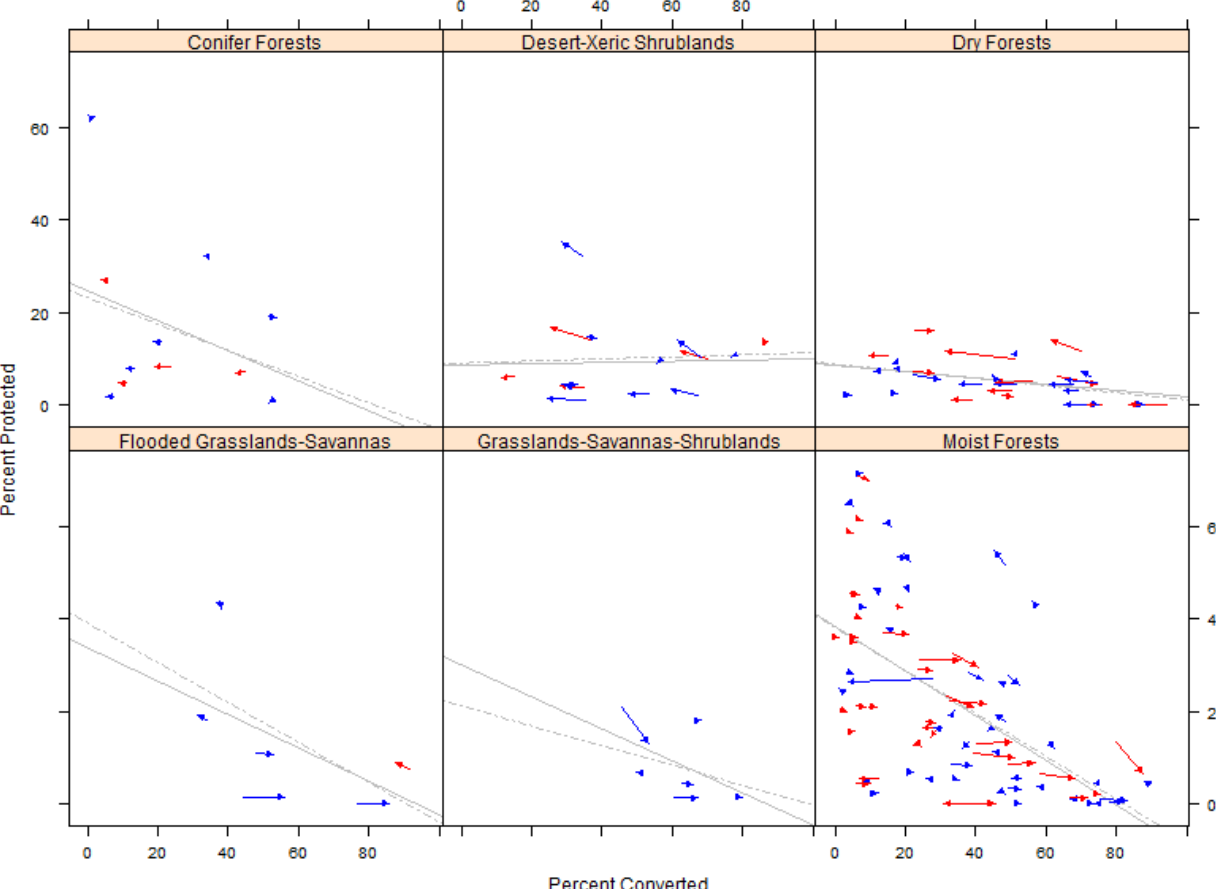
Figure 7. Percent of ecoregion converted (i.e., not woody) relative to the percent of ecoregion with protected woody, organized by biome for years 2001 (solid line) and 2010 (dashed line). Arrows indicate the direction and amount of change between 2001 and 2010. Red arrows are those ecoregions with significant trends in unprotected or protected areas ( p ≤ 0.10). ecoregions with <10% total woody cover were removed from the analysis.